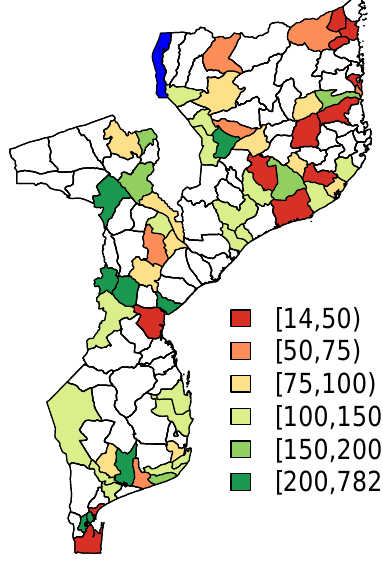
Figure 1. Sample size per district.